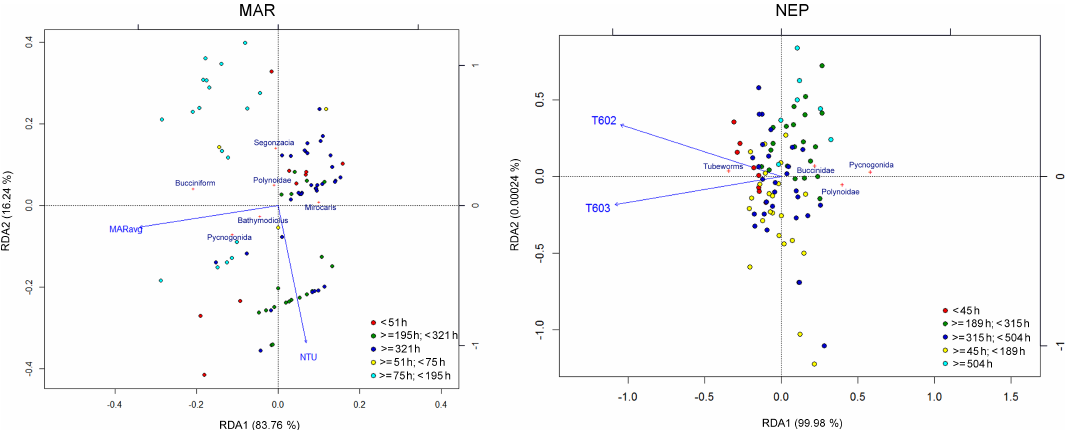
Figure 8. Redundancy analysis (RDA) ordinations featuring Hellinger-transformed faunal densities and environmental variables, both at a 6h frequency. MARavg is the temperature time series from the MAR and NTU is turbidity. T602 and T603 were the NEP temperature probes. Temporal splits groups were colour-coded in the ordination plots.